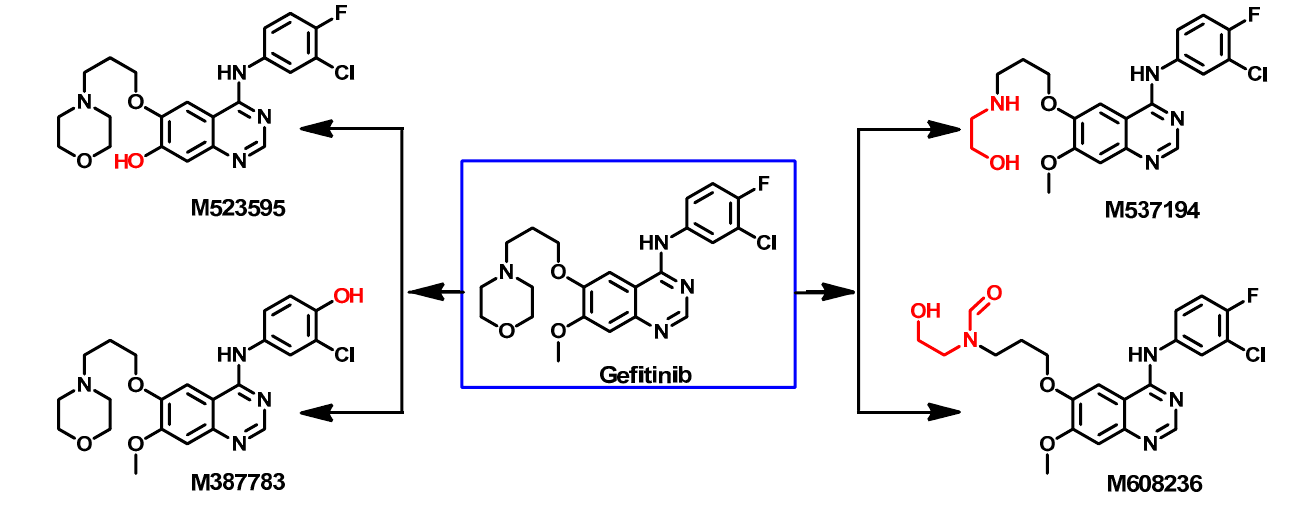
Figure 34. Proposed metabolic pathways of gefitinib.